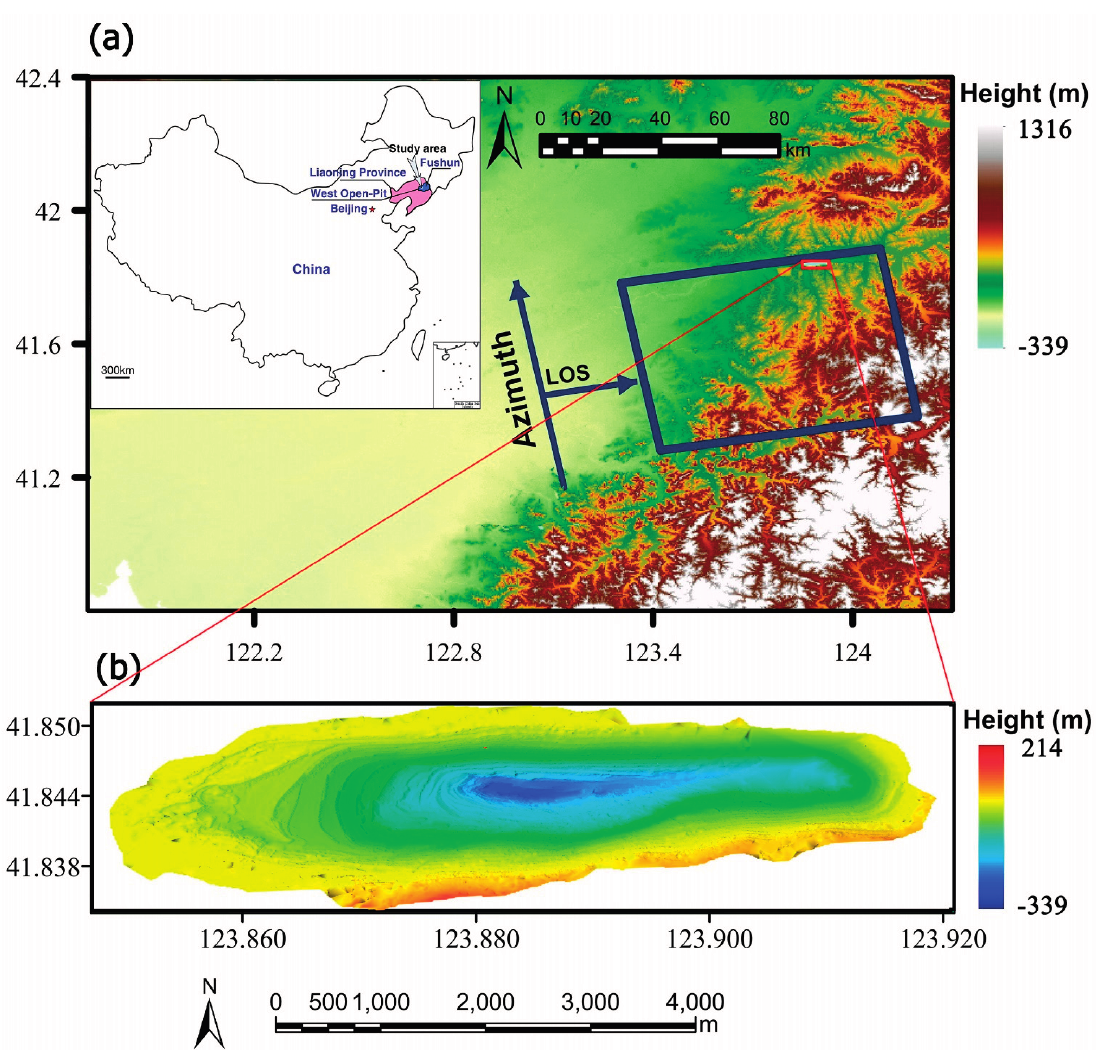
Figure 1. ( a ) Location of Fushun west open-pit mine (FWOPM). The blue box marked the coverage of the frame provided by the phased array type L-band synthetic aperture radar (PALSAR) sensor onboard the advanced land observing satellite (ALOS) in this study. The background is a shaded image of Shuttle Radar Topography Mission (SRTM) digital elevation model (DEM). The open-pit mine is specified by a red rectangle. The left-upper inset is a sketch map to mark the location of the study area in China. ( b ) The three-dimensional (3-D) topography presents the detailed morphology of the open-pit mine, which was obtained by 3-D laser scanning technology in